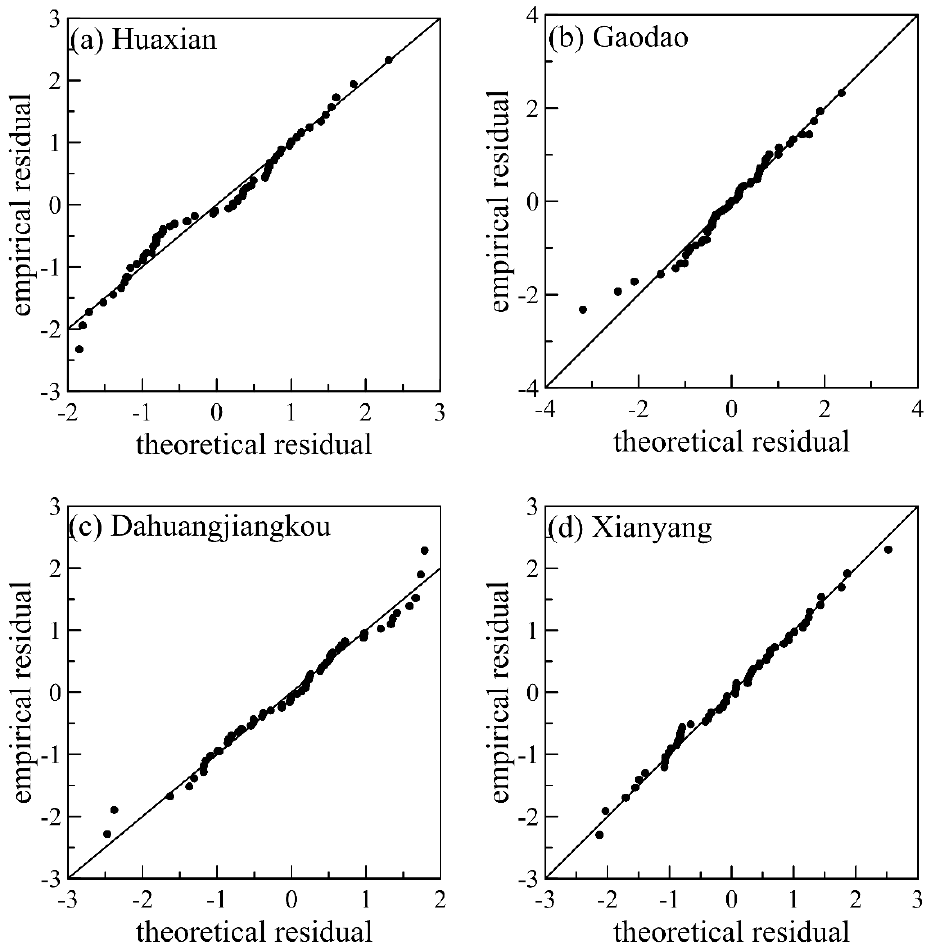
Figure 3. QQ map of the optimal non-stationary models for ( a ) Huaxian station; ( b ) Gaodao station; ( c ) Dahuangjiangkou station; ( d ) Xianyang station.